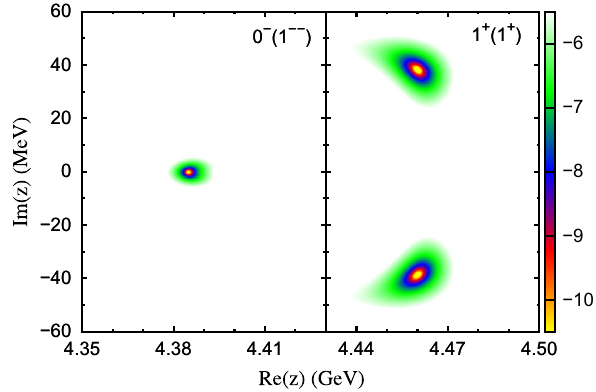
Fig. 2 The log | 1 − V ( z ) G ( z ) | for the D ∗ ¯ D 1 interaction. The results for the bound state with 0 − ( 1 −− ) ( left panel ) and the resonance state with 1 + ( 1 + ) ( right panel ) are drawn to the same scale 3 The numerical